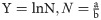
Log ratio of root length (A) and shoot length (B).
Y=lnN,N=ab in which a is the average value of root or shoot length, b is that of control. * indicates the difference was significant between the treatment and the control at P < 0.05.